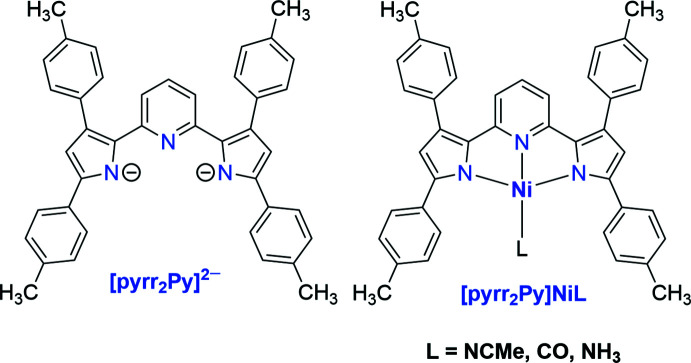
The dianionic, pyridine dipyrrolide pincer ligand [pyrr2Py]2− and the nickel(II) complexes.